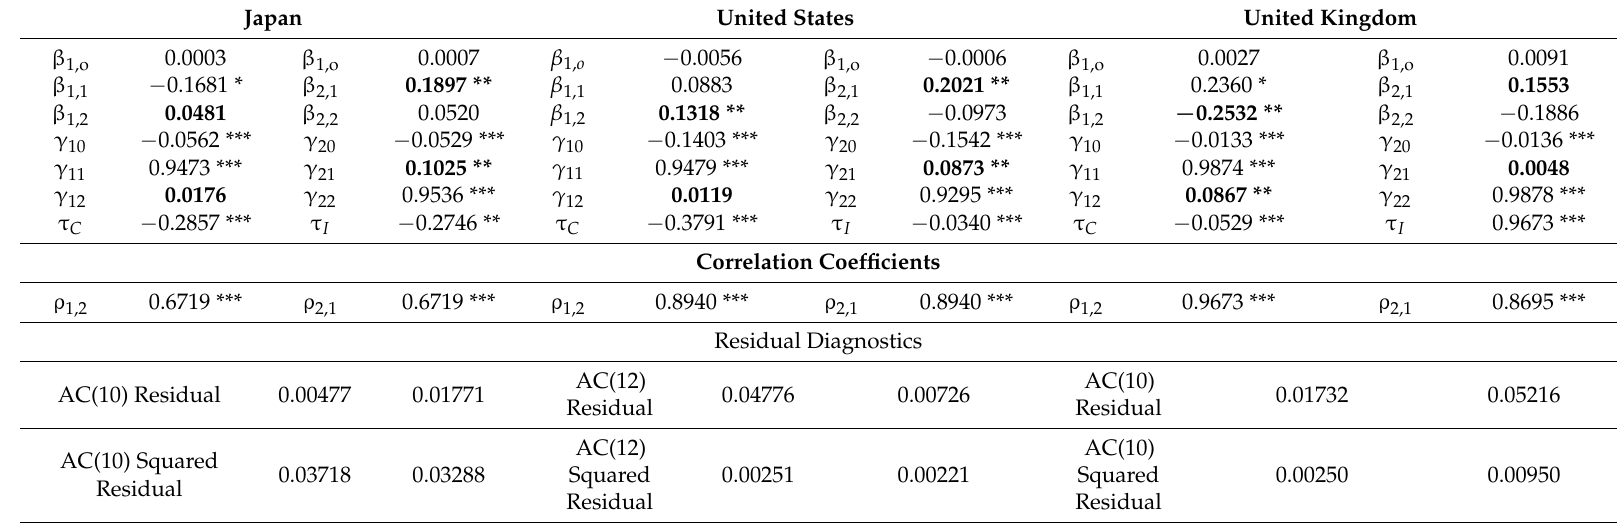
Table A2. Estimation from the bivariate VAR-EGARCH